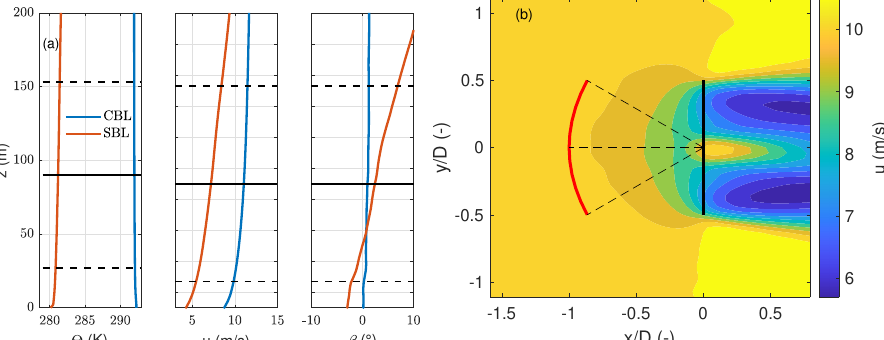
Figure 3. ( a ) Vertical profiles of the potential temperature, wind speed and wind veer at the end of the precursor run and ( b ) the averaged u -component at hub height extracted from the unstable LES wind field for the main run. The black vertical line indicates the position and size of the turbine rotor, and the red curve is the SpinnerLidar’s measurement